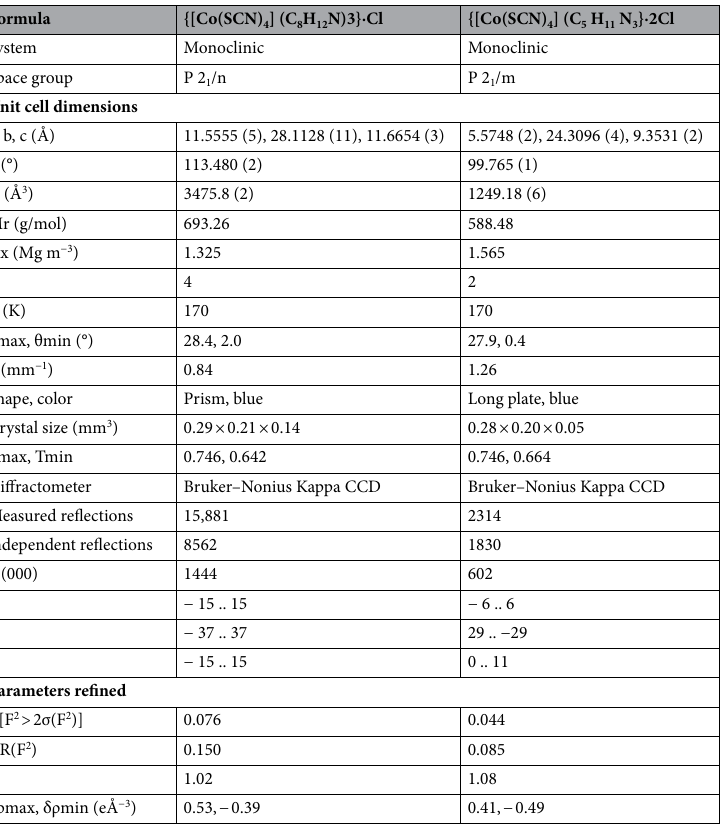
Table 1. Crystallographic Data for {[Co(SCN) 4 ] (C 8 H 12 N) 3 }·Cl and {[Co(SCN) 4 ] (C 5 H 11 N 3 ) 3 ]·2Cl. With w = 1/[σ 2